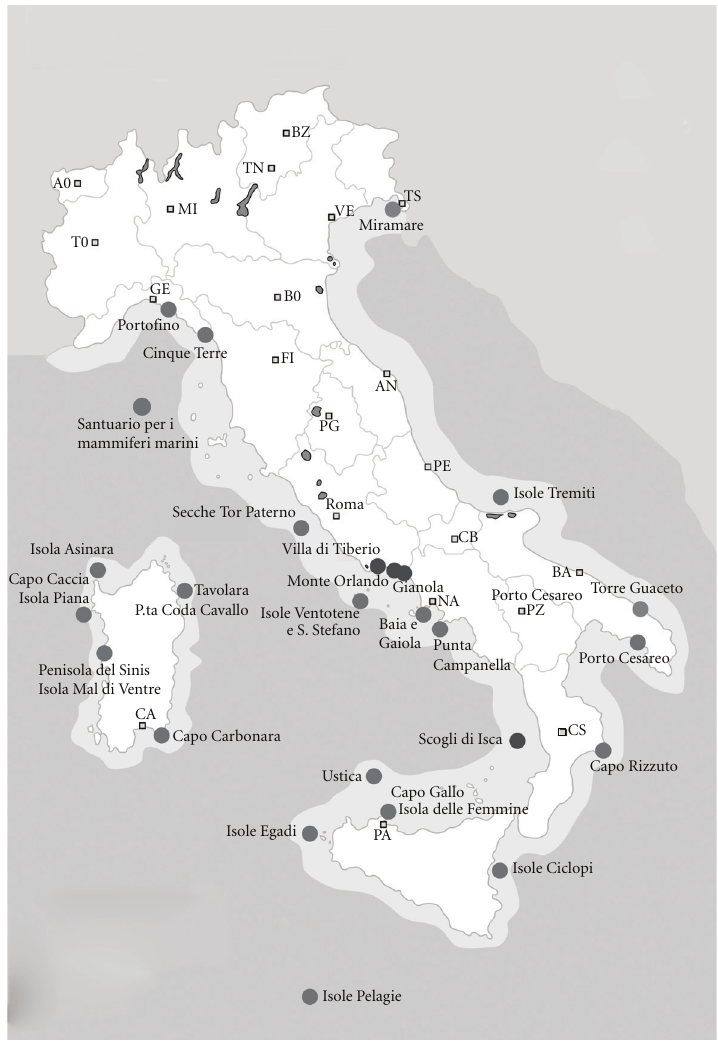
Figure 1: Italian MPAs updated to 2009 (redrawn from